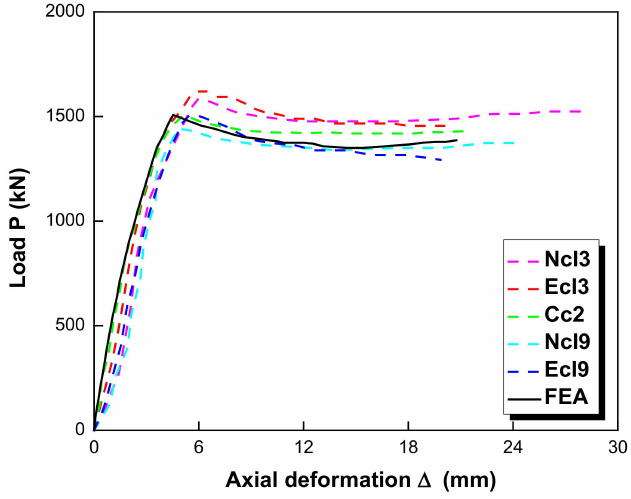
Figure 4. Axial load (P)—axial deformation ( ∆ ) of the FEA and the experimental tests for the CCFST [45–48,55–59].